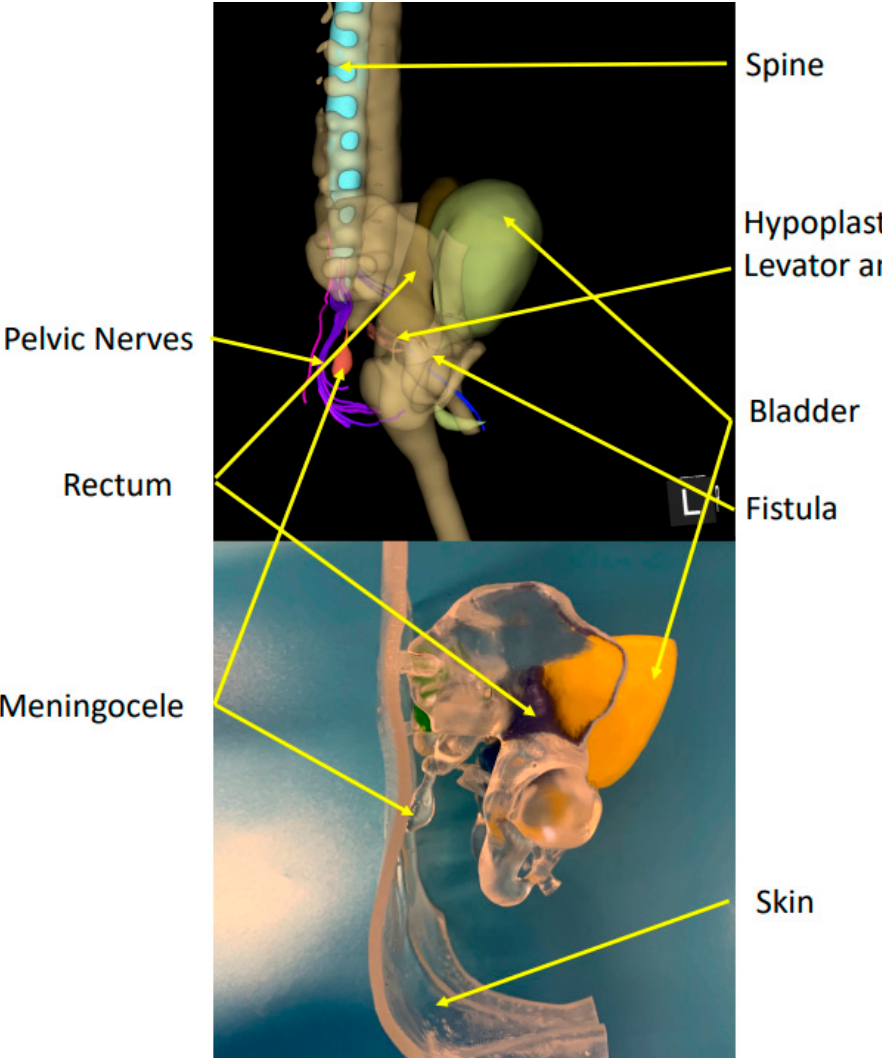
Figure 8. 3D Segmentation in 3D Slicer ( top ) and 3D printed model ( bottom ).